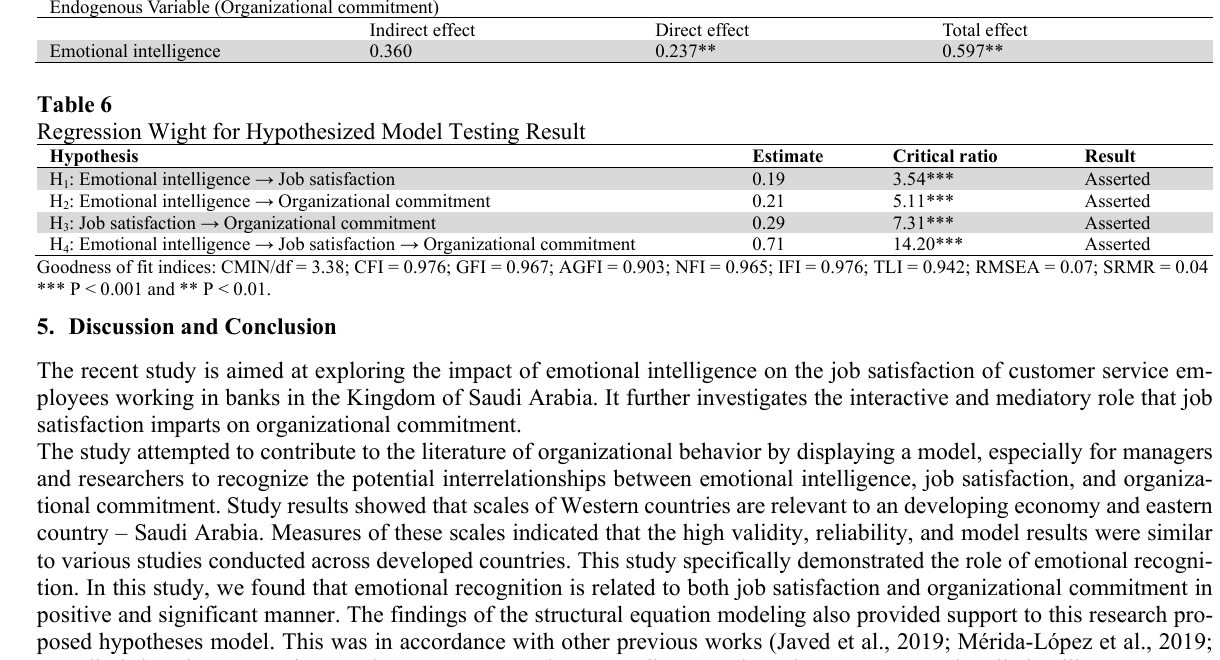
Indirect effect